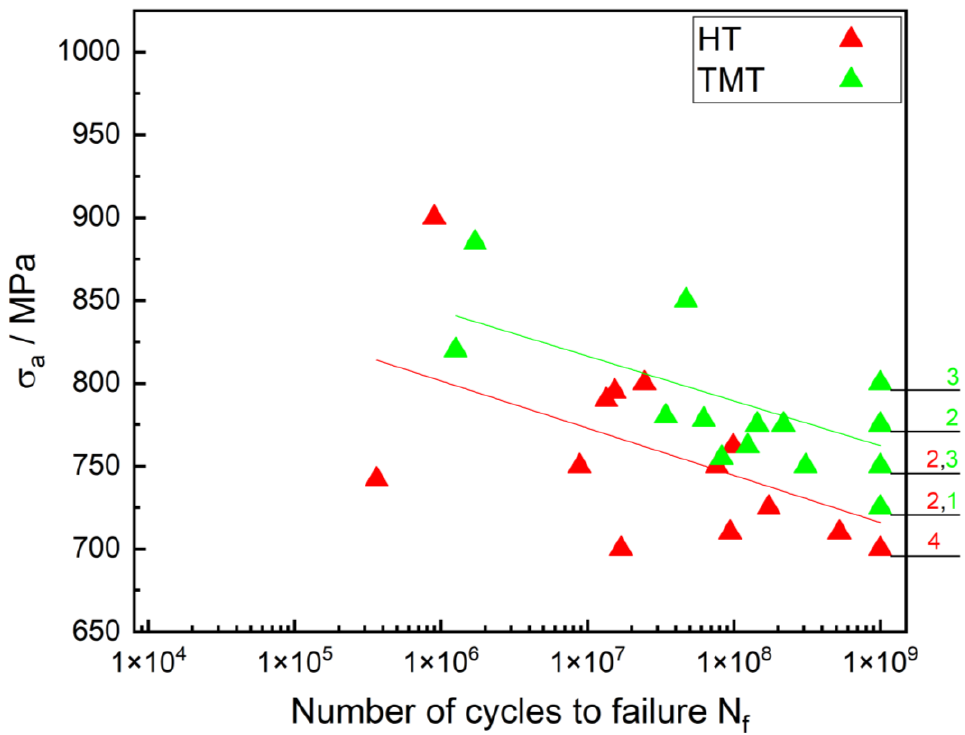
Figure 5. S – N curve for specimens with the TMT and HT in the VHCF regime. The numbers be- Figure 5. S–N curve for specimens with the TMT and HT in the VHCF regime. The numbers besides sides the data points at 10 9 cycles indicate the amount of run-out specimens. the data points at 10 9 cycles indicate the amount of run-out